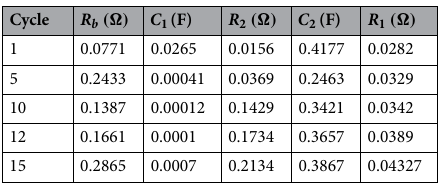
Table 2. Variation of system parameters (over-charge).